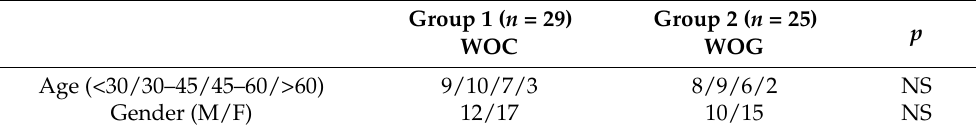
Table 3. Patient age and